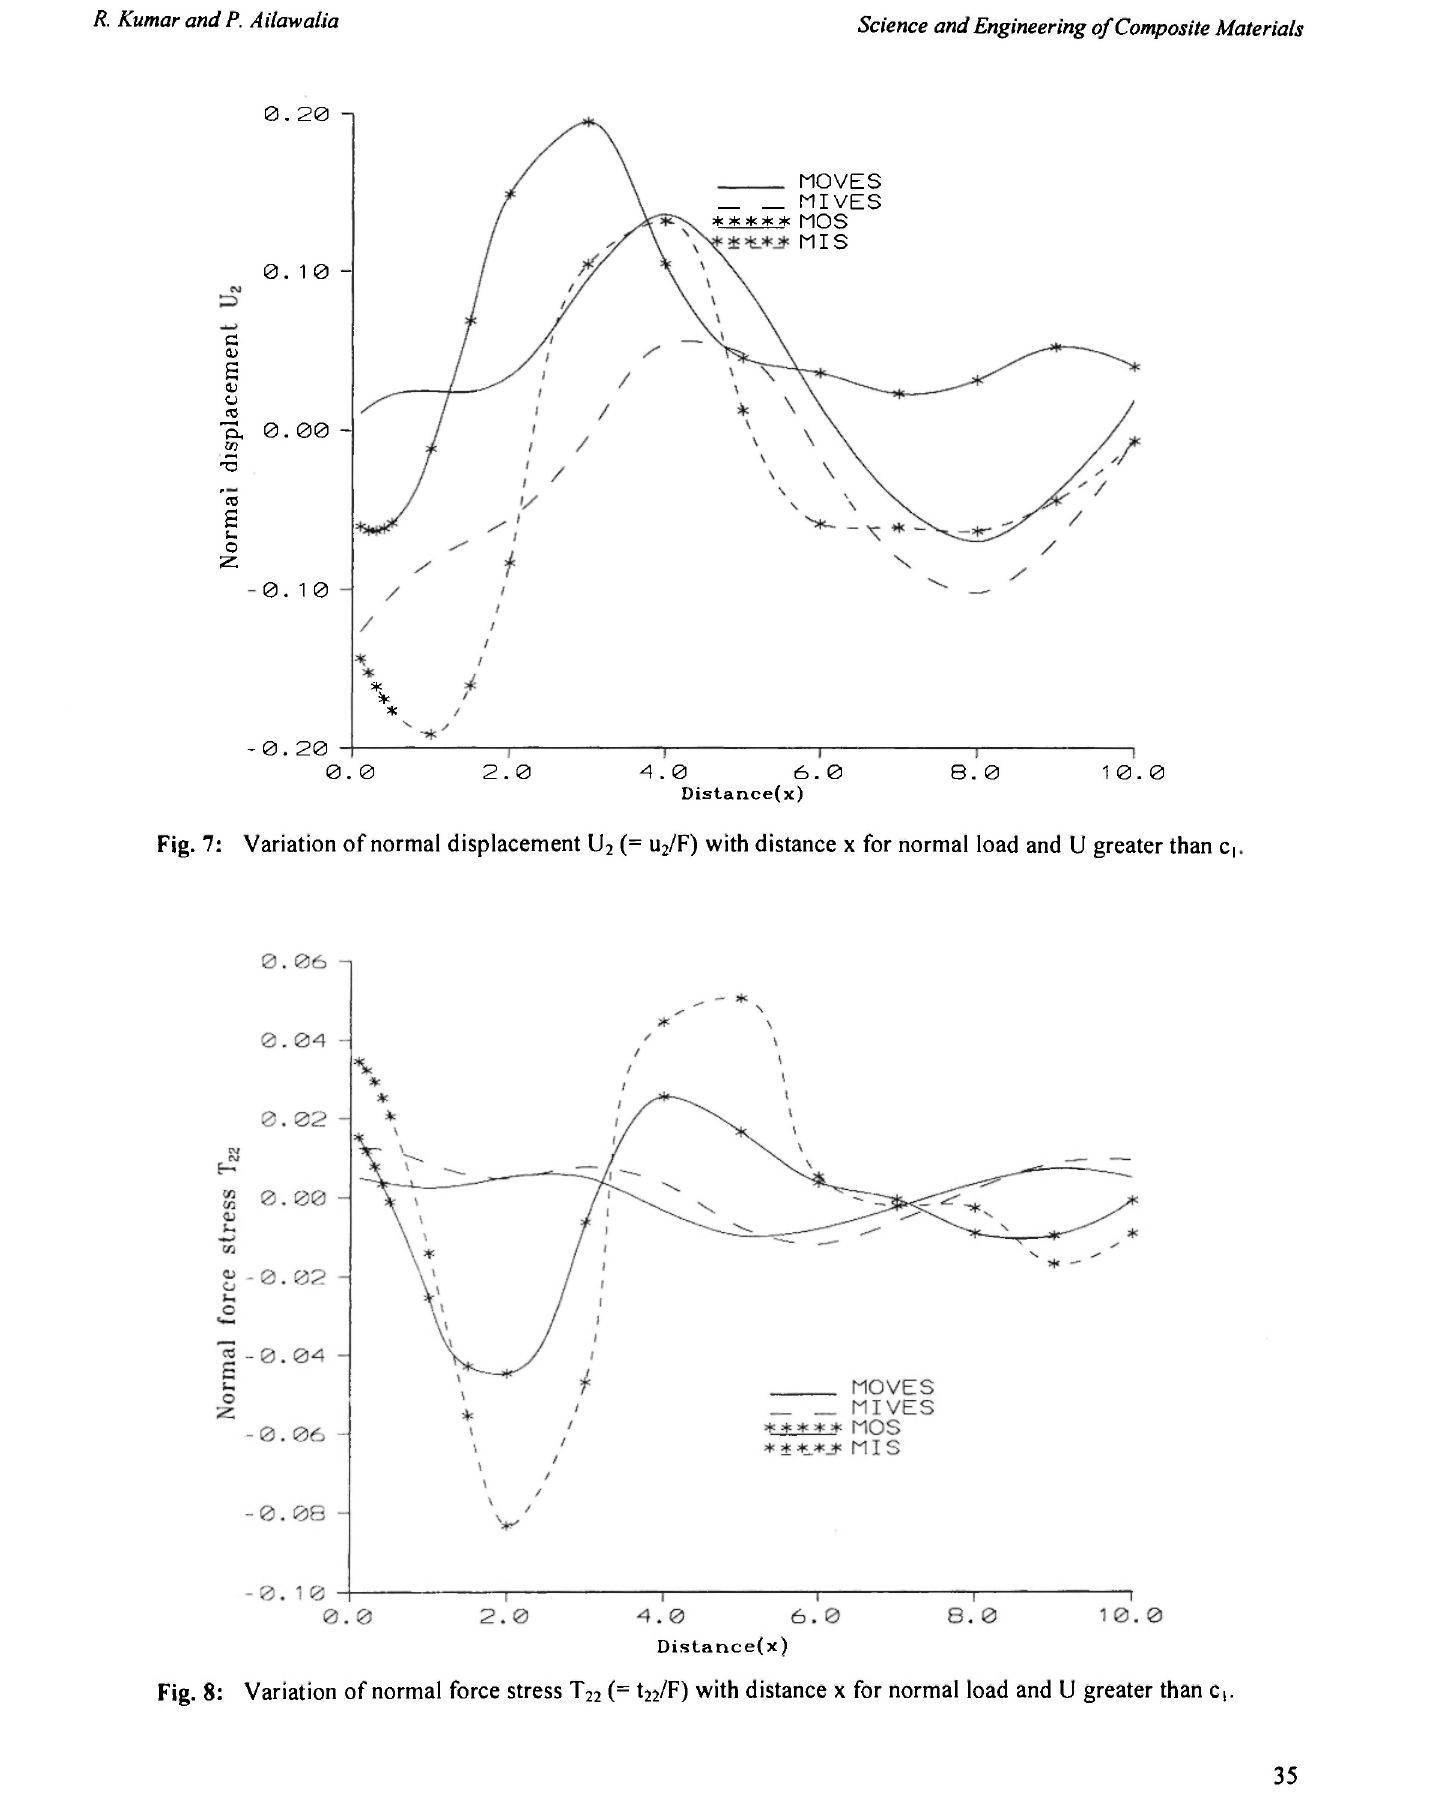
Variation of normal force stress T 22 ( = t 22 /F) with distance χ for normal load and U greater than